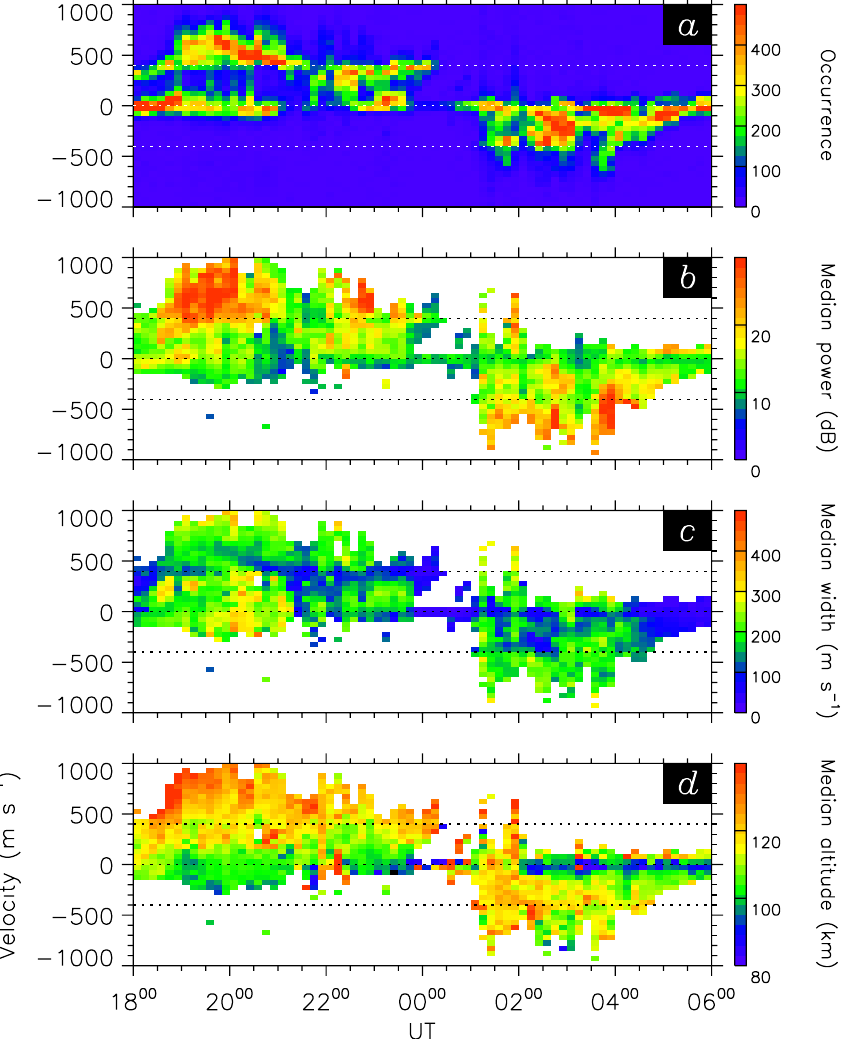
Fig. 5. (a) Five-minute occurrence distributions of Doppler shift from Channel A. (b–d) Median values of power, spectral width, and estimated altitude of scatter, respectively, where significant numbers of echoes are